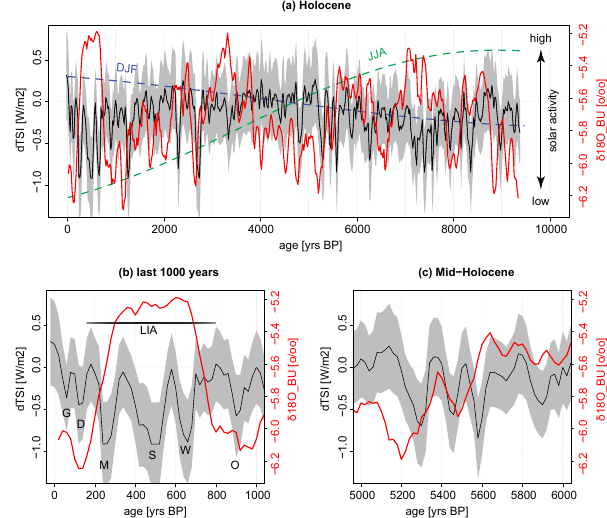
Fig. 1. (a) Reconstructions of solar activity (black) and measured δ 18 O changes of the BU4 record (red) at the Bunker Cave (Ger- many) during the mid- to late Holocene. The dashed lines show the relative trends of summer (JJA) and winter insolation (DJF) altered by orbital configuration changes. The plot shows the solar activity as the difference of total solar irradiance from the value during the solar cycle minimum of the year 1986AD (1365.57Wm − 2 ; Stein- hilber et al., 2012). Gray bands represent the 1-sigma uncertainty. (b) and (c) same as (a) but focusing on the last 1000yr and the mid- Holocene, respectively. Capital letters mark grand solar minima: G: Gleissberg, D: Dalton, M: Maunder, S: Sprorer, W: Wolf, O: